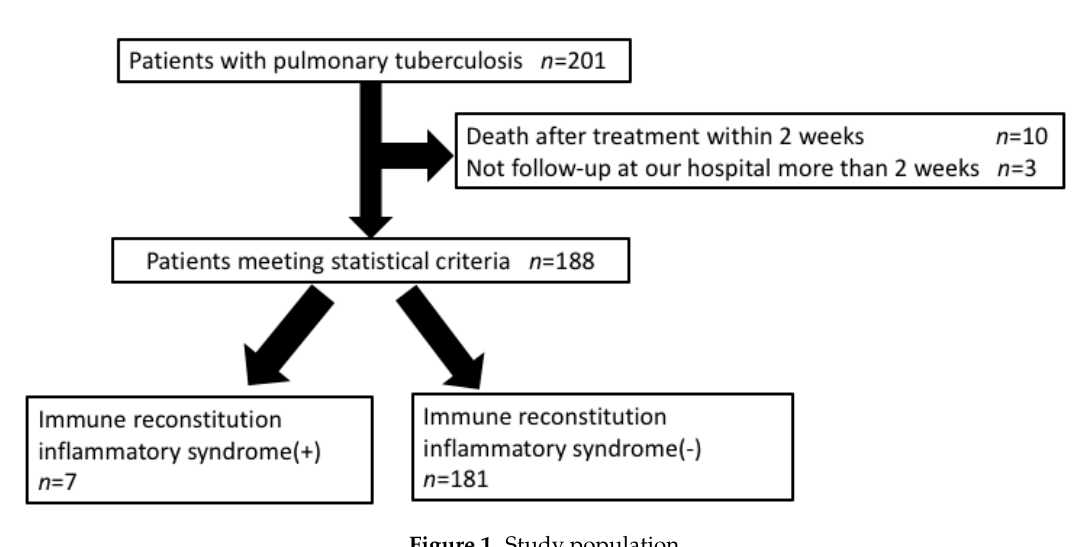
Table 2. Background factors with or without immune reconstitution inflammatory syndrome